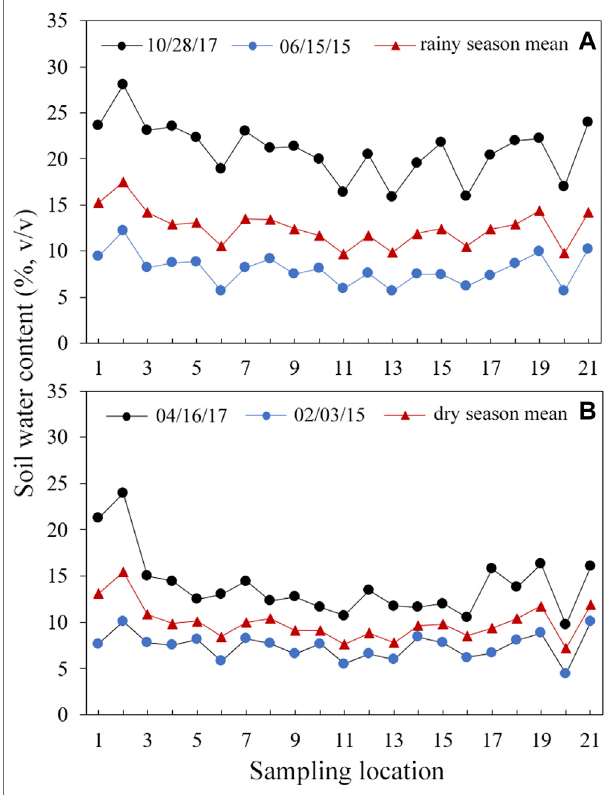
FIGURE 3 | Mean SWC Change of 21 locations in the rainy season (A) and dry season (B) on the driest and wettest dates in the depth of 100